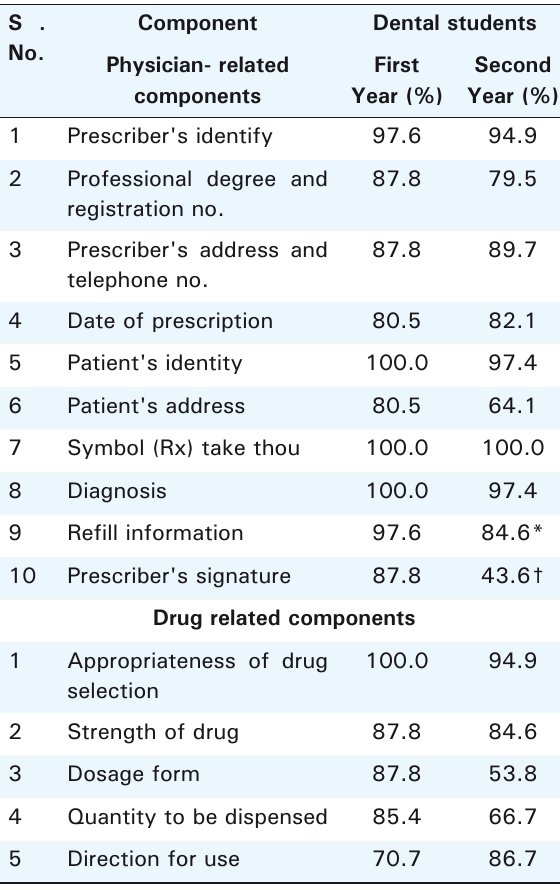
table 1. Performance in prescription writing skill amongst first and second year MBBS students S.